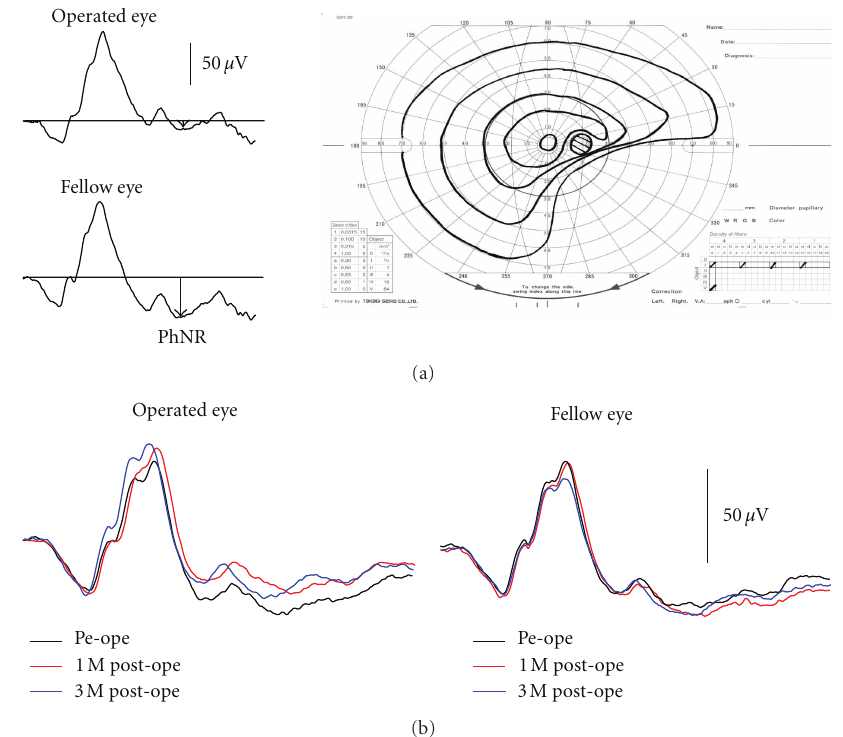
Figure 12: (a) Representative case of macular hole who complained of visual field defect in the operated eye after surgery. (b) Changes of the full-field cone electroretinograms recorded from a patient with a macular hole pre- and postoperatively. PhNR: photopic negative